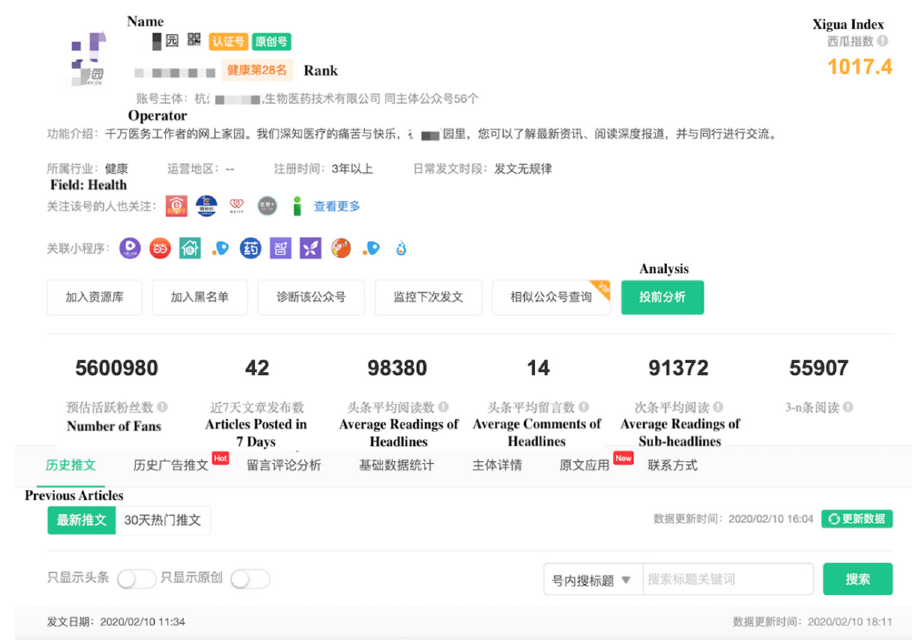
Figure 3. Screenshot of the data collection page. Some important nouns and items were translated into English. From: Xigua Data. Detailed Data of Official Accounts. Available online: http://data.xiguaji.com/Home#/Rank/IndustryNew?Period=30&tid=4 (accessed on 10 April 2020).